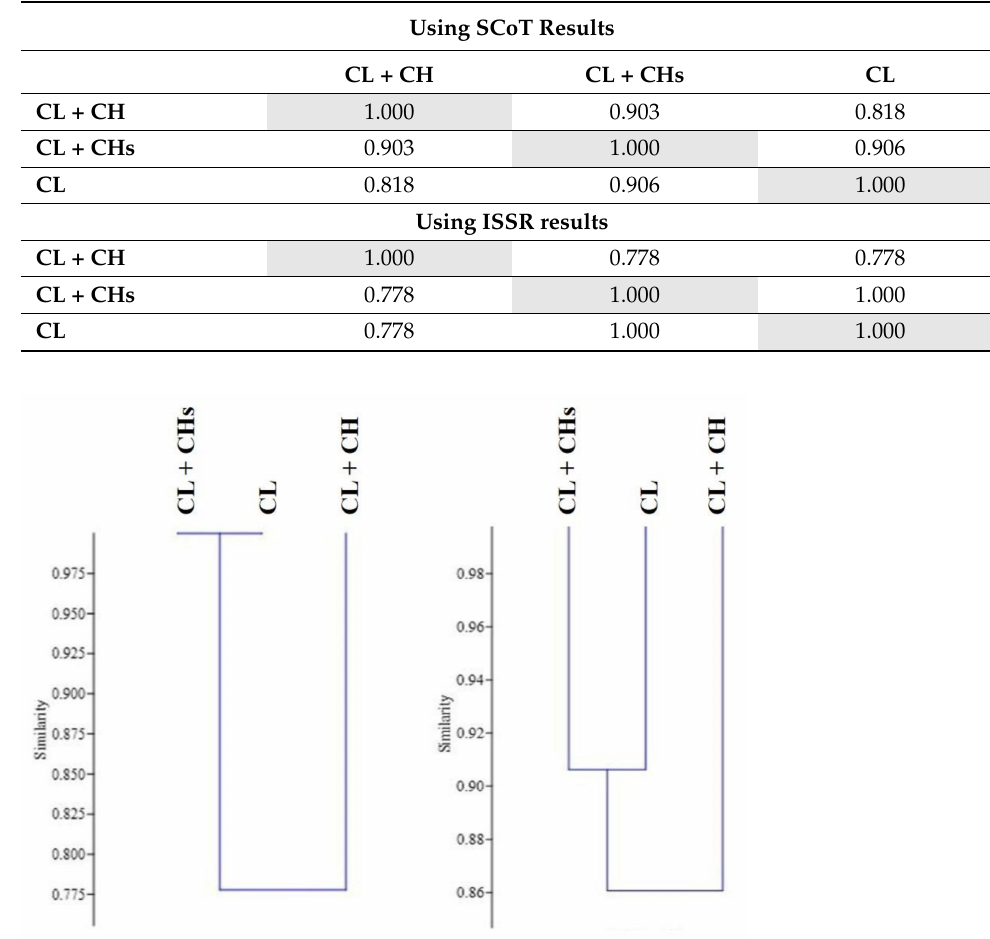
Table 1. Genetic similarity between the studied morphs using Jaccard’s coefficient.